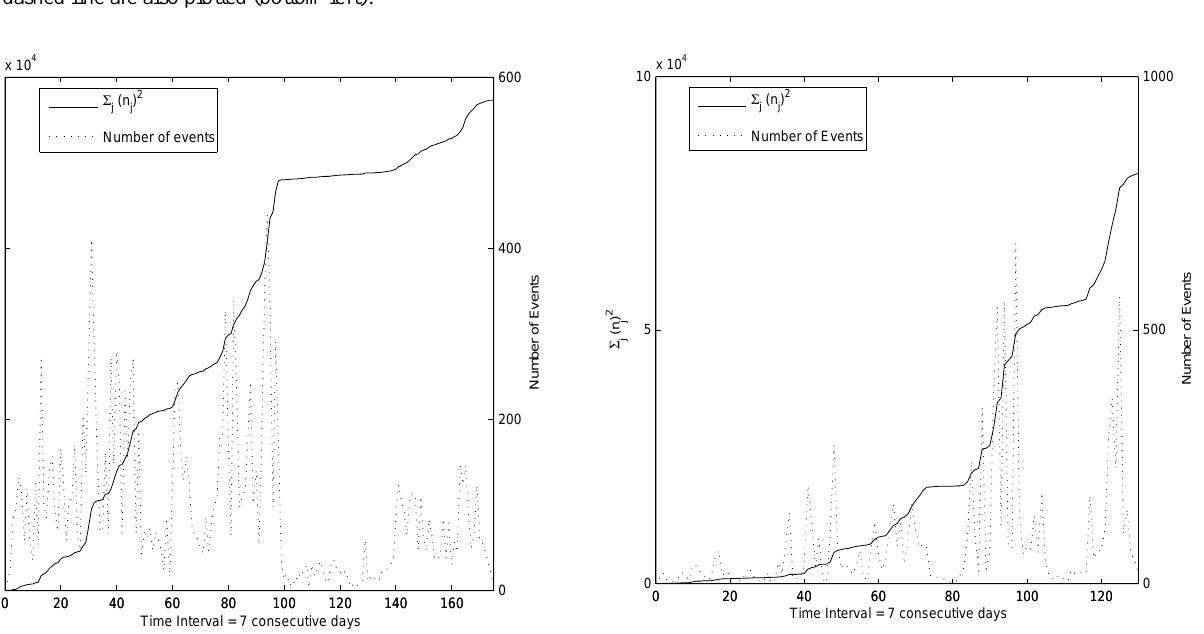
Fig. 6. Distribution of events around the 1989 Loma Prieta earthquake: before the mainshock (top left), after the mainshock (top right) and up until the mainshock since 1932 (bottom right). The approximation in Eq. (4) with the time of occurrence of the 1989 Loma Prieta event as the dashed line are also plotted (bottom left).